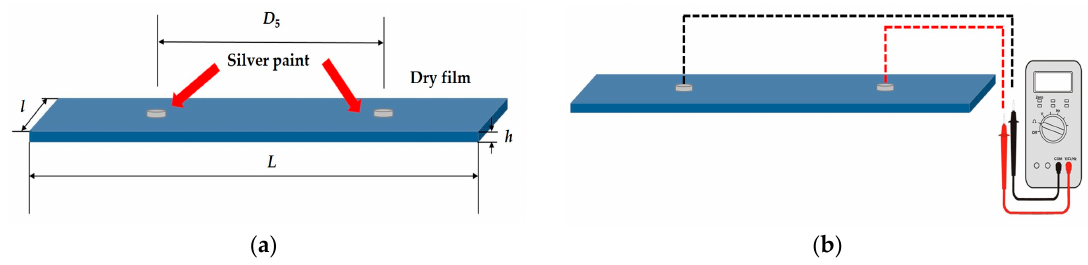
Figure 3. Conductive dry films preparation ( a ) and electrical resistance measurements by a standard Ohmmeter at distance of 5 cm between silver points ( b ).